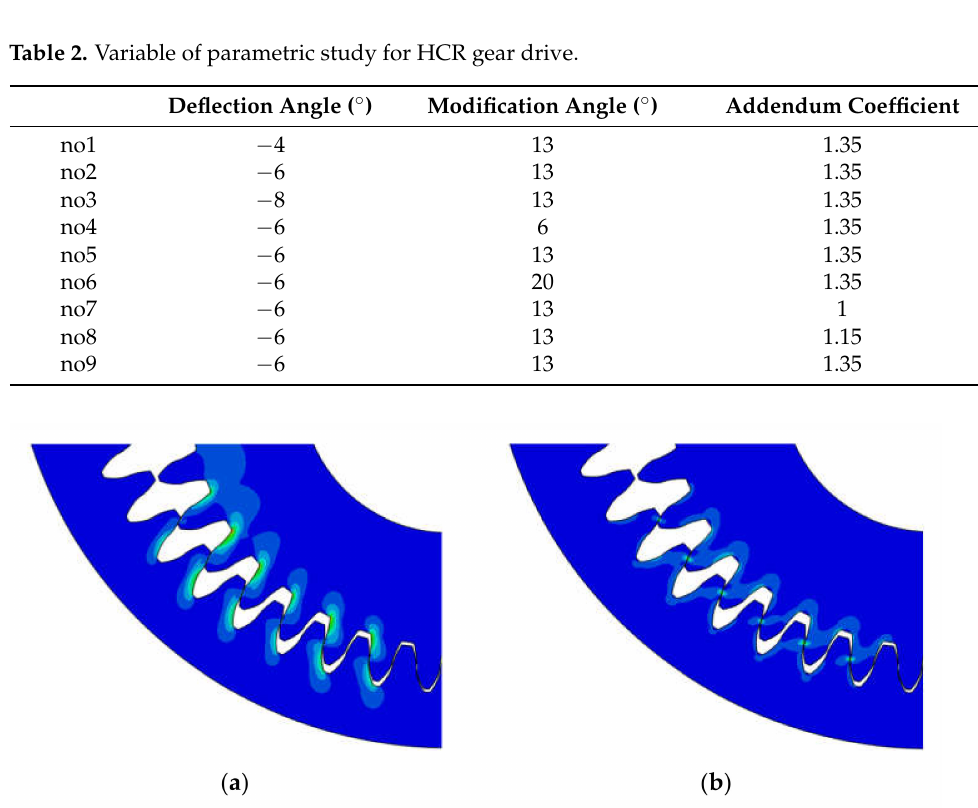
Figure 11. Results of 2D FEM: ( a ) maximum principal stress; ( b ) von Mises